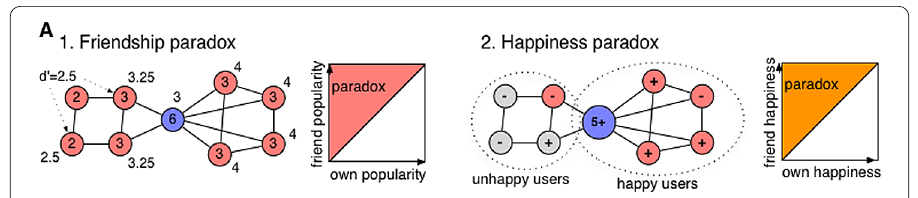
Figure 1 A Happiness paradox, like a Friendship paradox, could result from skewed degree distributions. (A1) Like the examples above, most social networks are characterized by very skewed degree distributions: a few individuals have very many connections, while most individuals have only few connections. The number of connections are marked within each node. Those with many connections are by definition more likely to be someone’s friend. As a result their higher number of connections can increase the average degree of given friendship neighborhoods throughout the network (marked above each node) leading to a Friendship paradox (red nodes) in which most individuals nodes are less popular than the average of their friends. (A2) When popular individuals are also more likely to be happy, their Happiness becomes more prevalent, raising average happiness levels throughout the friendship circles in the network. A Happiness paradox may result in which most individuals are less happy than their own friends on average. Individuals may cluster based on their Happiness or even the degree to which they experience a Happiness